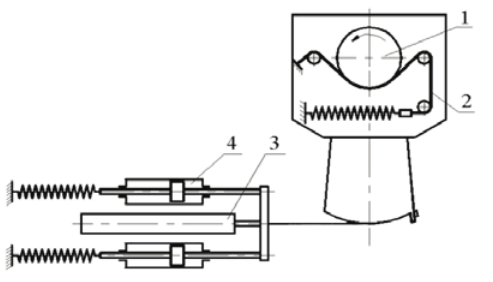
Fig. 2. Diagram of a tribometer (1 – sample; 2 – steel tape as a mating sample; 3 – friction torque transmitter; 4 – air